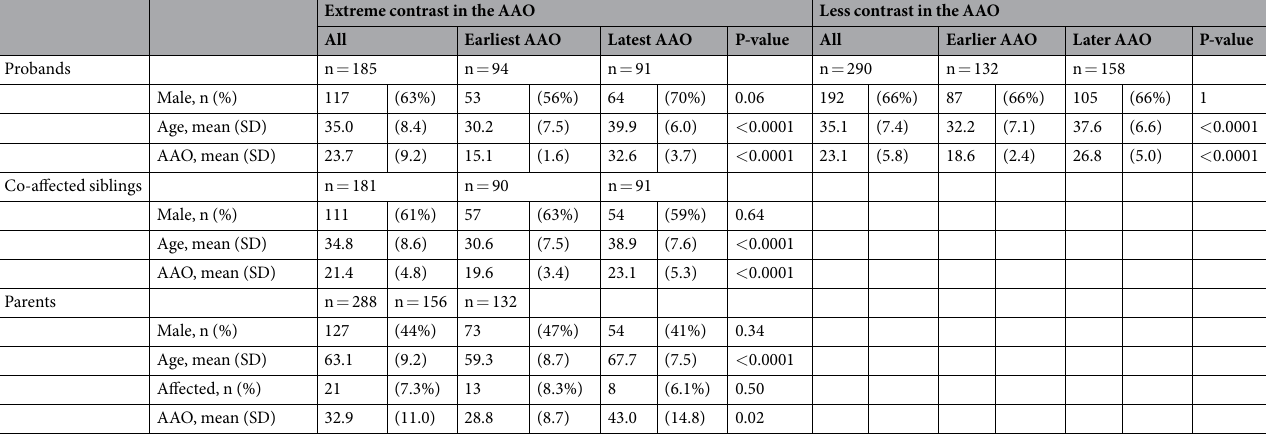
Table 1. Comparison of gender, age, and age at onset distribution of the family samples with extreme and less contrast in the age at onset. AAO: age at